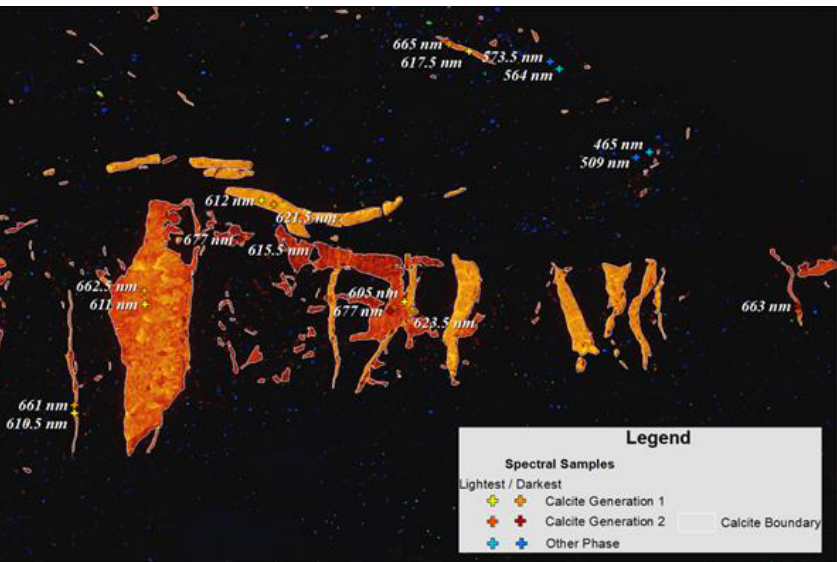
Figure 7. ArcGIS map view of sample points within the local coordinates of the CL image, labeled with custom symbology and relevant attribute information regarding spectral wavelength and calcite generation association.